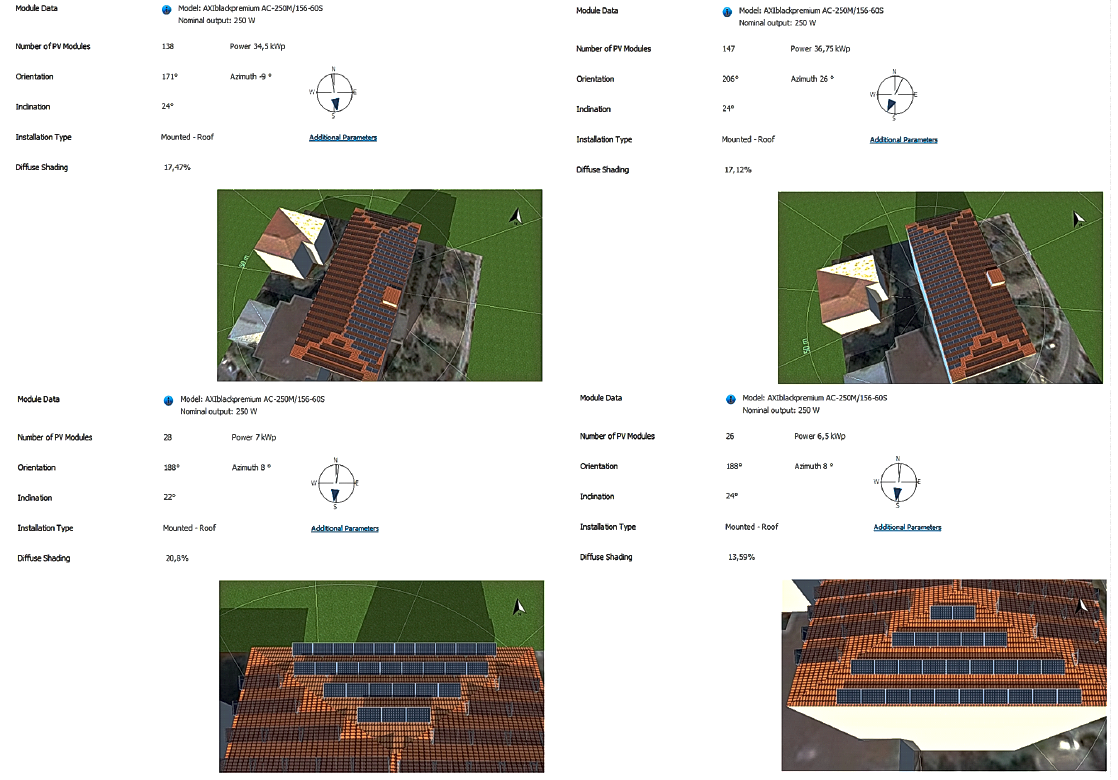
Figure 9. Four subsystem the east-west-north-south groups of PV modules.